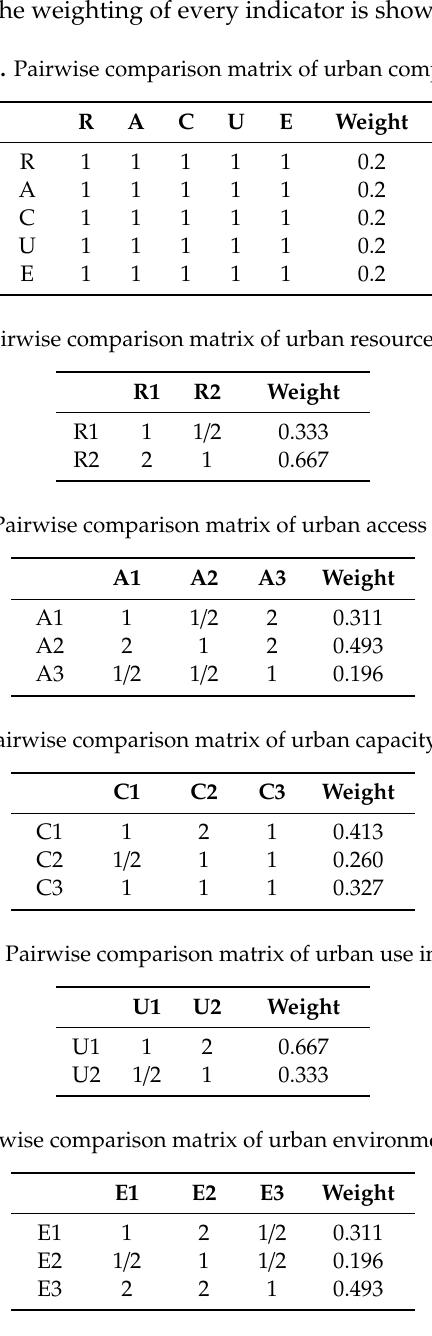
Table A7. Pairwise comparison matrix of rural